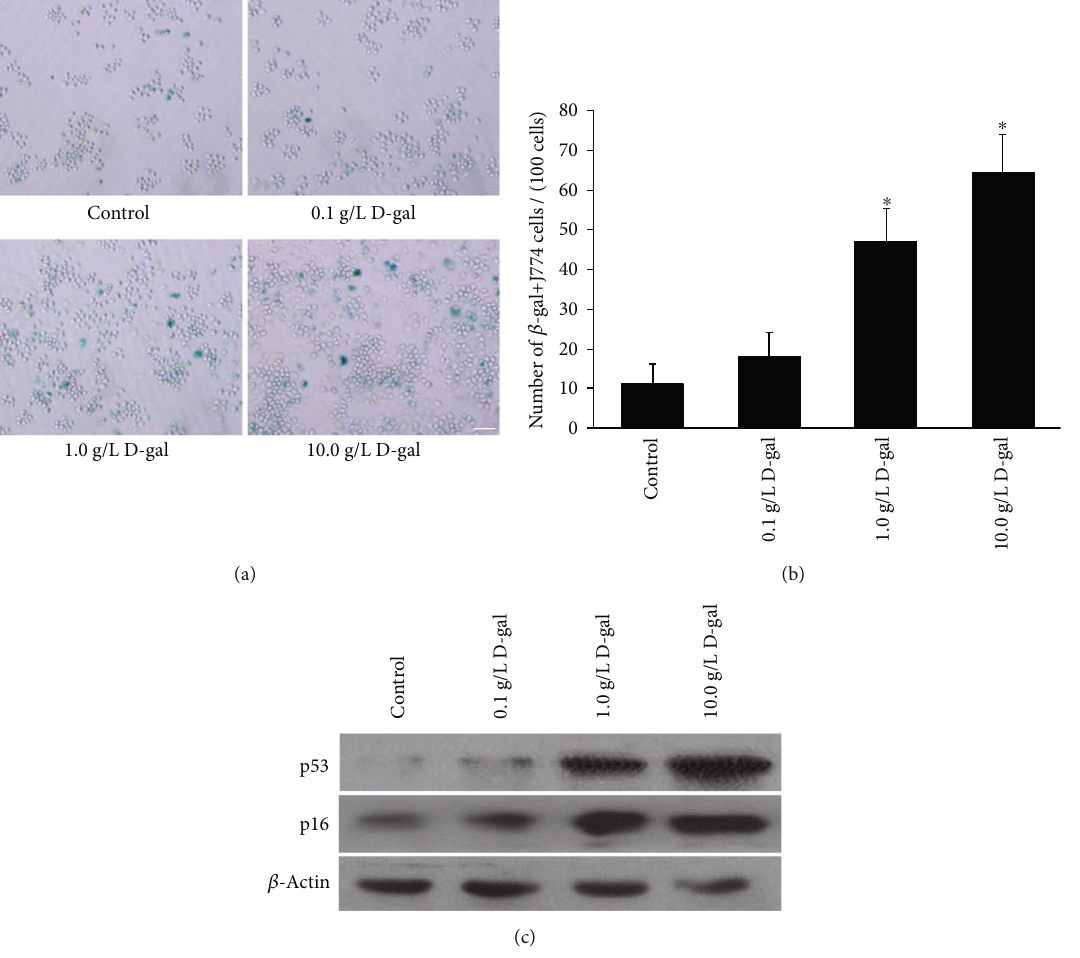
Figure 1: E ff ects of D-gal on J774A.1 macrophage senescence. (a) SA- β -gal staining. With the increase in D-gal concentration, the number of SA- β -gal-positive cells increases in the 1 and 10g/L D-gal group. Scale bar = 50 μ m . (b) SA- β -gal staining cell quanti fi cation. The total number of SA- β -gal-positive cells among 100 random cells was determined through phase-contrast microscopy. The results showed that the number of SA- β -gal-positive J774A.1 cells/100 cells in the 1.0 and 10.0 D-gal groups remarkably increased compared with that in the control group ( ∗ P < 0 : 01 , n = 5 ). (c) Western blot analysis of p53 and p16 expression levels. The p53 and p16 expression levels were gradually higher in the 0.1, 1.0, and 10.0g/L D-gal groups compared with those in the control group. β -Actin was used as the internal